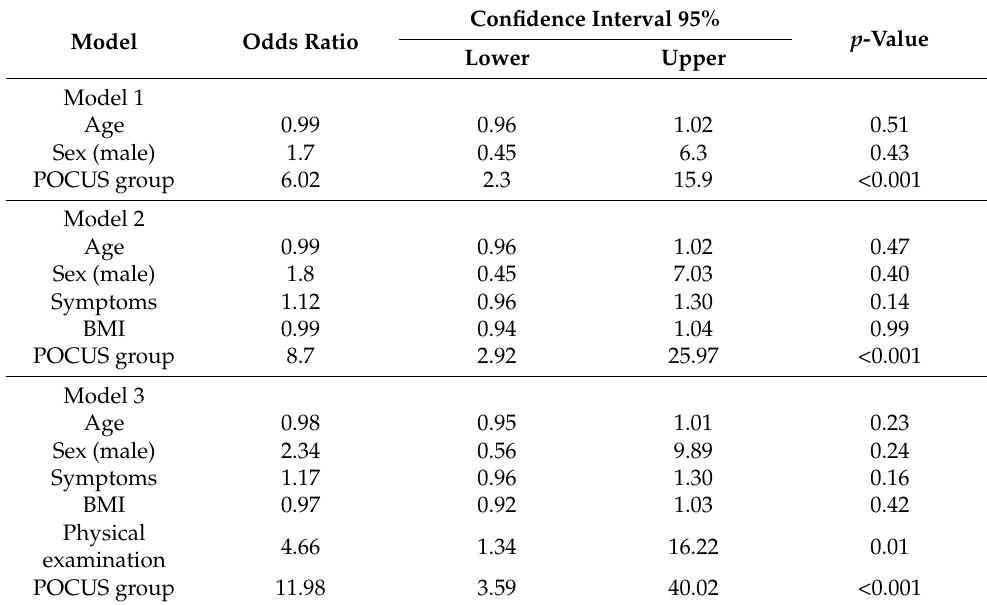
Table 3. Models for management change rate factors among two study cohorts.